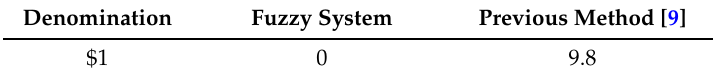
Table 5. Comparison of mean EER between the proposed method and a previous method. (unit: %)